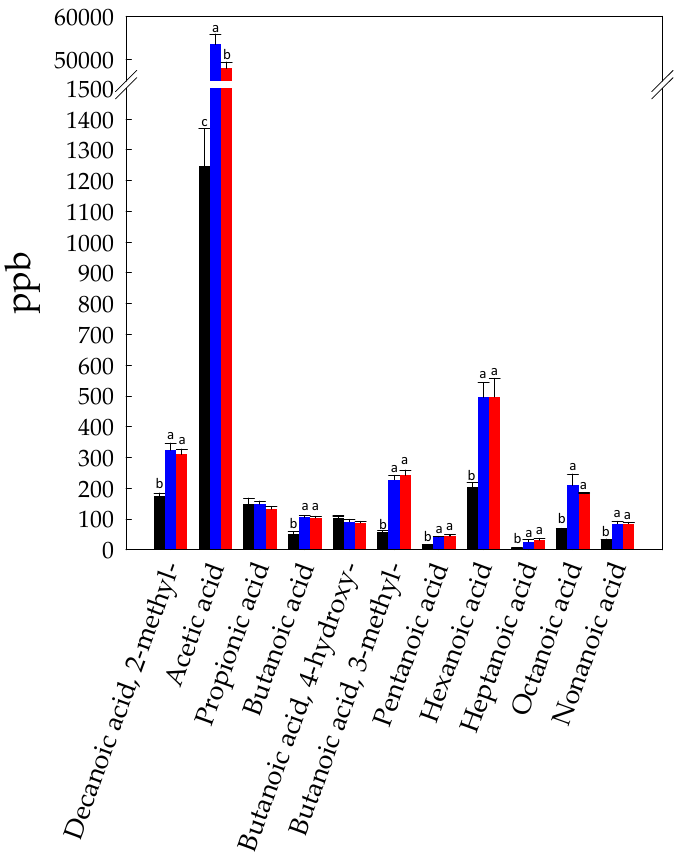
Figure 2. Concentration (ppb) of volatile free fatty acids identified in Raw- (black bars), Unstarted- (blue bars), and Started-BCP (red bars). Data are the means ( ± SD) of three independent experiments analyzed in triplicate. Data were subjected to one-way ANOVA; pair-comparison of treatment means was achieved by Tukey’s procedure at p < 0.05. For each compound, bars with different superscript letters differ significantly ( p < 0.05).